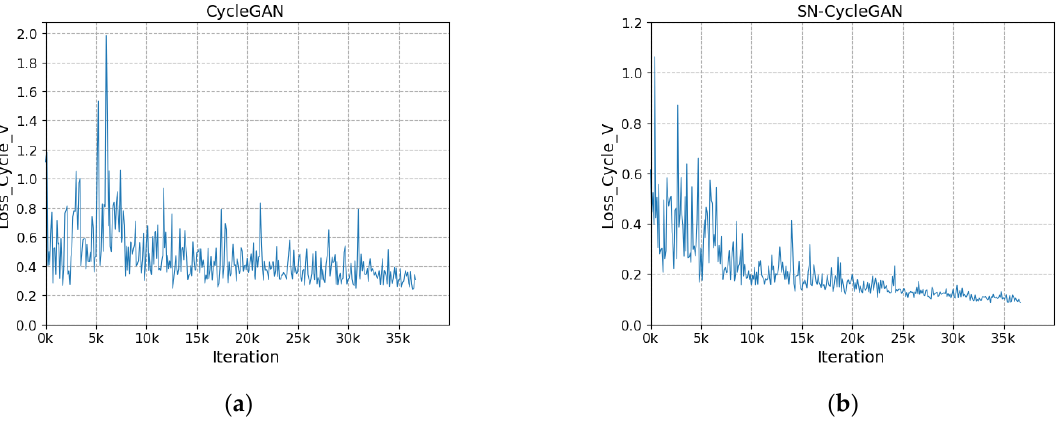
Figure 9. Comparison of cycle loss for visible light. ( a ) CycleGAN, ( b ) SN-CycleGAN.